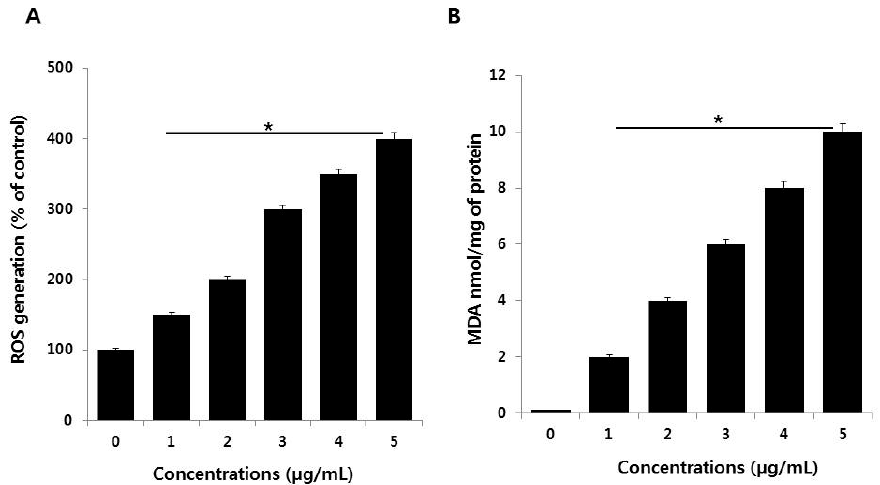
Figure 4. ( A ) Measurement of ROS ( B ) MDA levels in SKOV3 cells. There was a significant difference in the ratio for PdNPs-treated cells compared to that in untreated cells, as determined by the Student’s t -test (* P <